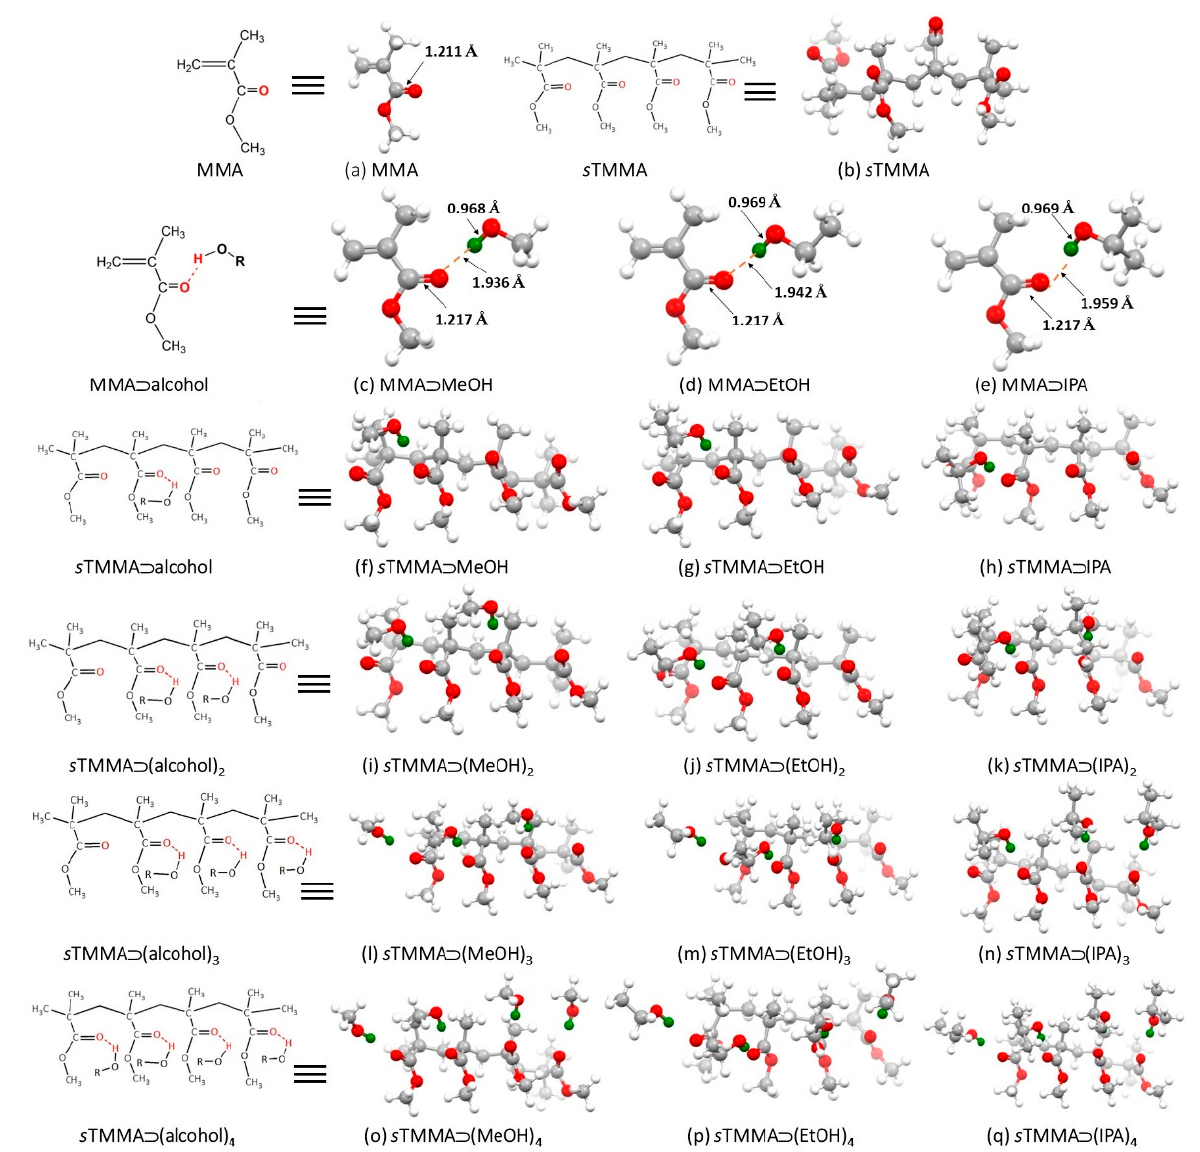
Figure 6. Formulas and optimized ball-and-stick molecular structures of: Top row: ( a ) MMA, ( b ) the all-syn -tetrameric segment of PMMA (“ s TMMA”). Second row: ( c ) MMA ⊃ MeOH, ( d ) MMA ⊃ EtOH and ( e ) MMA ⊃ IPA. Third row: ( f ) s TMMA ⊃ MeOH, ( g ) s TMMA ⊃ EtOH and ( h ) s TMMA ⊃ IPA. Fourth row: ( i ) s TMMA ⊃ (MeOH) 2 , ( j ) s TMMA ⊃ (EtOH) 2 and ( k ) s TMMA ⊃ (IPA) 2 . Fifth row: ( l ) s TMMA ⊃ (MeOH) 3 , ( m ) s TMMA ⊃ (EtOH) 3 and ( n ) s TMMA ⊃ (IPA) 3 . Sixth row: ( o ) s TMMA ⊃ (MeOH) 4 , ( p ) s TMMA ⊃ (EtOH) 4 and ( q ) s TMMA ⊃ (IPA) 4 . Color code: carbon = black grey, oxygen atom = red, and all hydrogen atoms = white except for the alcohol hydrogen atoms = green.